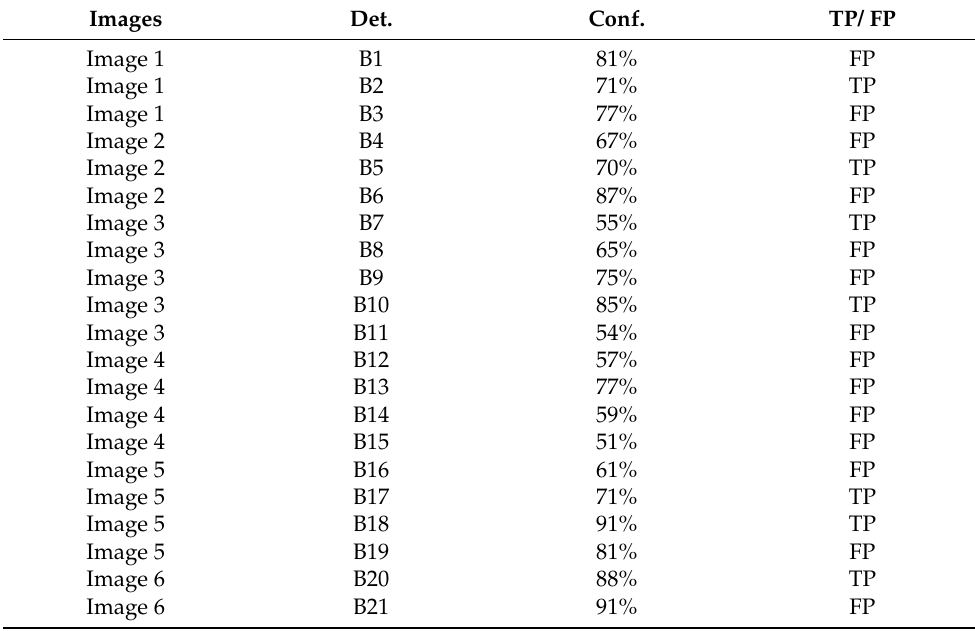
Table 3. True and false positive-detected bounding boxes with their corresponding confidence levels. Det. and Conf. denote detection and confidence,